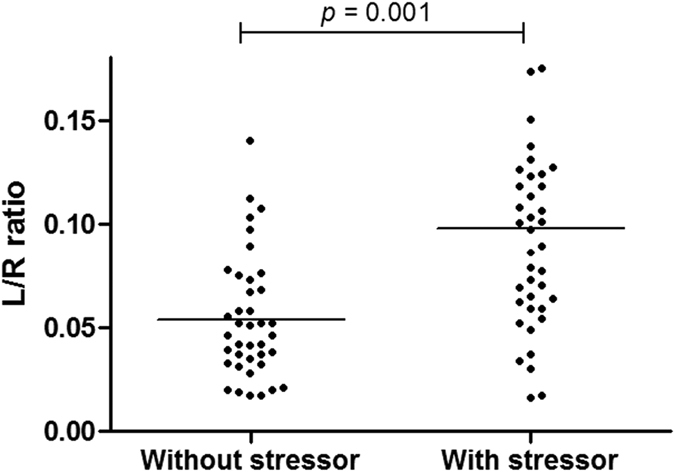
Indomethacin significantly increases intestinal permeability.Study participants were subjected to a sugar-based permeability test. Ratio of lactulose and rhamnose (L/R ratio) was determined in 5 hr urine samples of subjects without indomethacin stressor (day-3) or with stressor (day 0) before intake of the permeability test. Mean ± SD of L/R ratio without stressor = 0.058 ± 0.037 and with stressor = 0.098 ± 0.056. Differences tested with Linear Mixed Models, adjusting for repeated measurements for each subject.